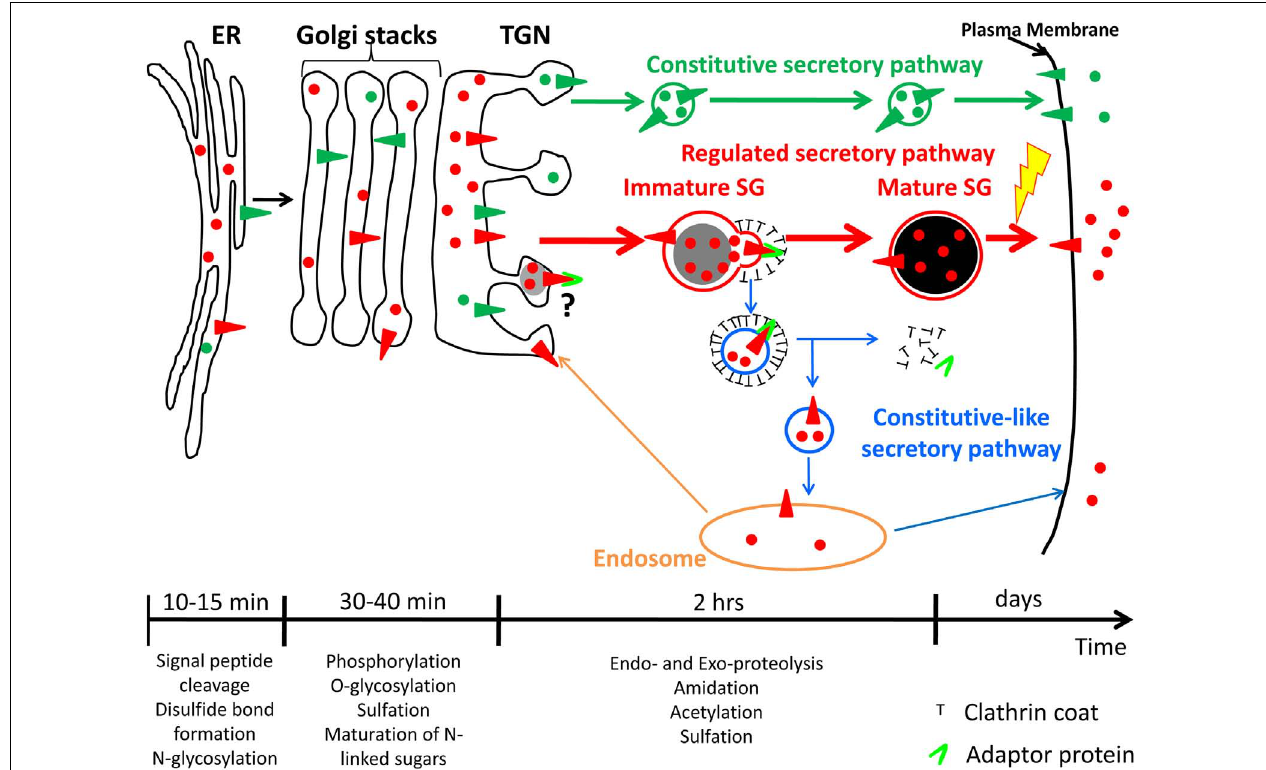
constitutive secretory vesicles or immature secretory granule (SGs) in the TGN. Immature SGs undergo a maturation process to become mature SGs. The yellow lightning bolt represents the external stimulus triggering secretion of mature SG content.The maturation process involves remodeling of immature SG membranes, generating the constitutive-like secretory pathway (blue); the fate of the vesicles leaving immature SGs is not clear; return to an endosomal compartment from which proteins can be secreted in a constitutive-like fashion or recycled to theTGN is shown. ER, endoplasmic